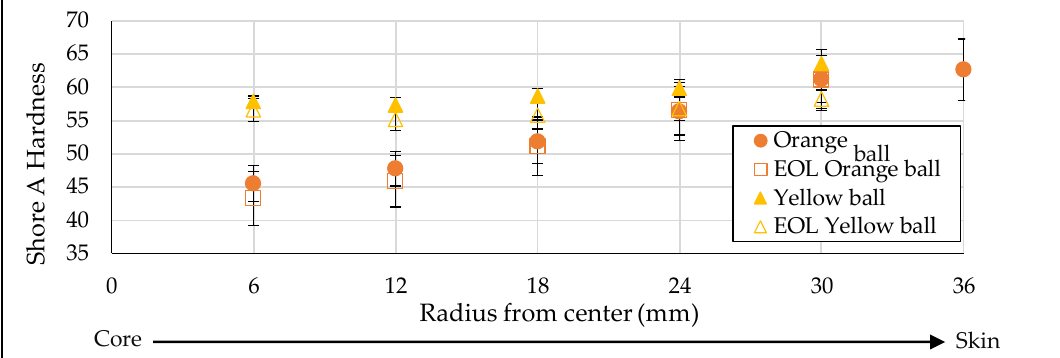
Figure 3. Inside hardness with error bars represent one standard deviation at each